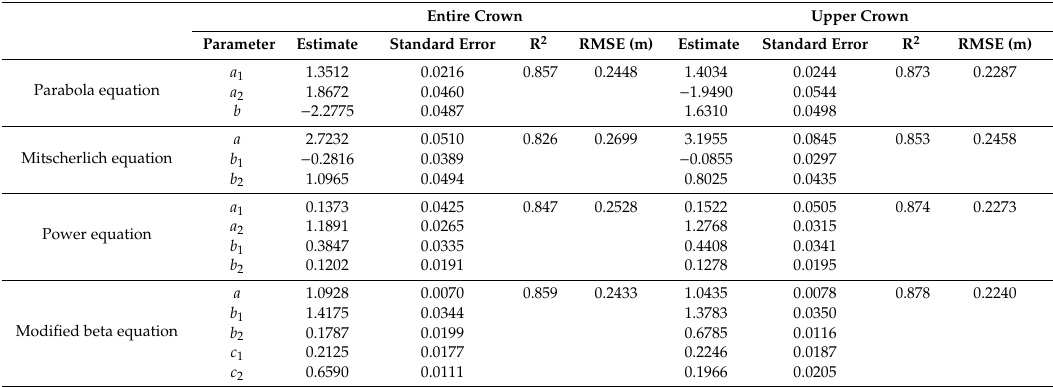
Table 4. Estimates of the parameters and goodness-of-fit statistics for the four crown profile models obtained from the 95th width percentile